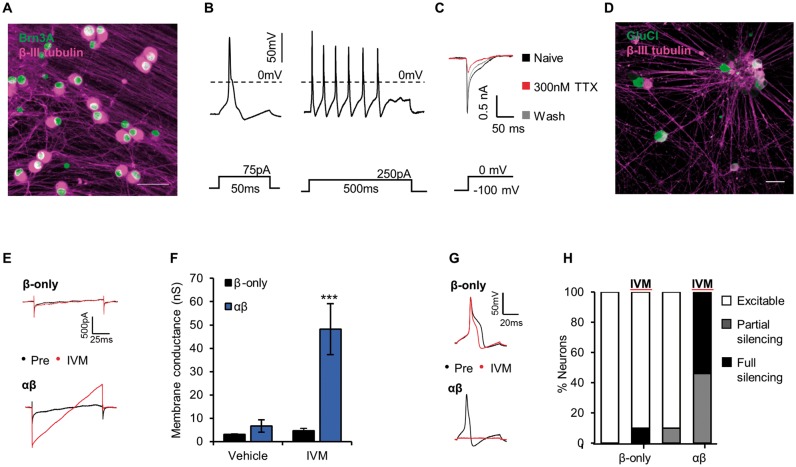

GluCl activation silences human iPSC-derived sensory neurons. (A) Mature human iPSC-derived sensory neurons stain positive for the sensory neuron transcription factor Brn3a (green) and neuronal marker β-III tubulin (magenta). Scale bar = 50 μm. (B) Evoked firing in response to short (left) and long (right) depolarizing current injection. Note the inflection on the falling phase of the action potential—a property of endogenous nociceptors. (C) Example voltage clamp recording demonstrating both a TTX-sensitive and a TTX-resistant component to the Na+ current evoked by membrane depolarization to 0 mV. (D) GluCl expression in human iPSC-sensory neurons 2 weeks following treatment with GluCl-AAV. Scale bar = 50 μm. (E) Voltage ramp recordings of neurons expressing GluCl and treated with ivermectin (IVM, 20 nM). (F) Quantification of membrane conductance of neurons pretreated with either ivermectin (20 nM) or vehicle (0.01% DMSO). Kruskal-Wallis followed by post hoc Dunn’s test comparing groups to control (vehicle treated β-only): vehicle β-only, n = 9; vehicle αβ, n = 11; ivermectin β-only, n = 11; and ivermectin αβ, n = 13. (G) Evoked firing in response to supra-threshold current injection pre- and post-ivermectin treatment. (H) Neuronal excitability as defined based on a rheobase value; <3 (excitable), 3–10 (partial silencing) or >10 (full silencing) standard deviations above the mean of control (vehicle treated β-only, mean = 103 ± 28.2 pA). P < 0.001, chi-squared test (χ2 = 32.45 with 6 degrees of freedom); vehicle β-only, n = 9; vehicle αβ, n = 11; ivermectin β-only, n = 11; and ivermectin αβ n = 13. All grouped data are mean ± SEM, ***P < 0.001.